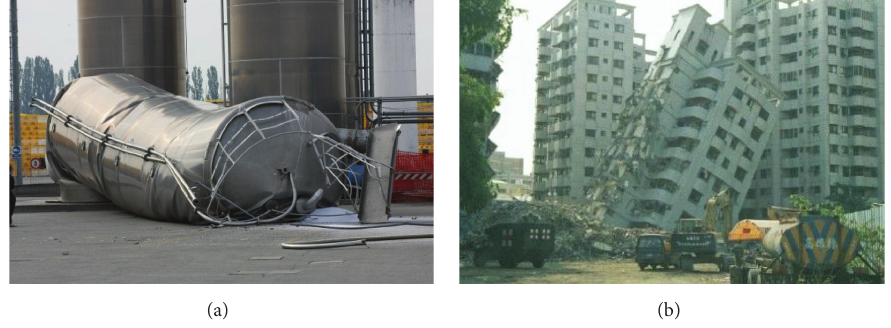
Figure 1: Catastrophic collapses due to earthquakes.